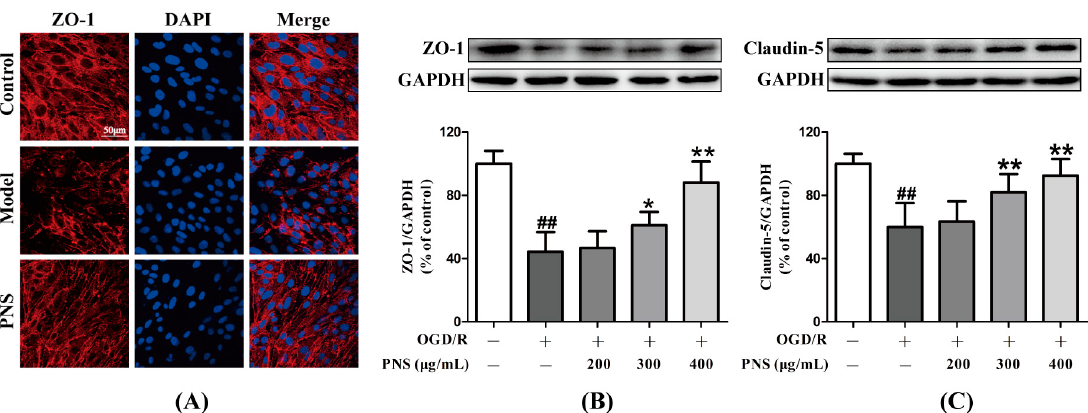
Figure 4. The protective effects of PNS against OGD4h/R12h-induced degradation of TJ proteins. ( A ) Representative confocal microscopy images showing the immunostaining of ZO-1 after OGD/R and PNS (400 µ g/mL) intervention in bEnd.3 cells. Scale bar = 50 µ m. The expression levels of ZO-1 ( B ) and claudin-5 ( C ) were measured by Western blot. The band intensities were assessed by Image J software and normalized against the GAPDH signal. Data are expressed as the mean ± SD (N = 3). ## p < 0.01 vs. Control group, * p < 0.05 and ** p < 0.01 vs. Model group.